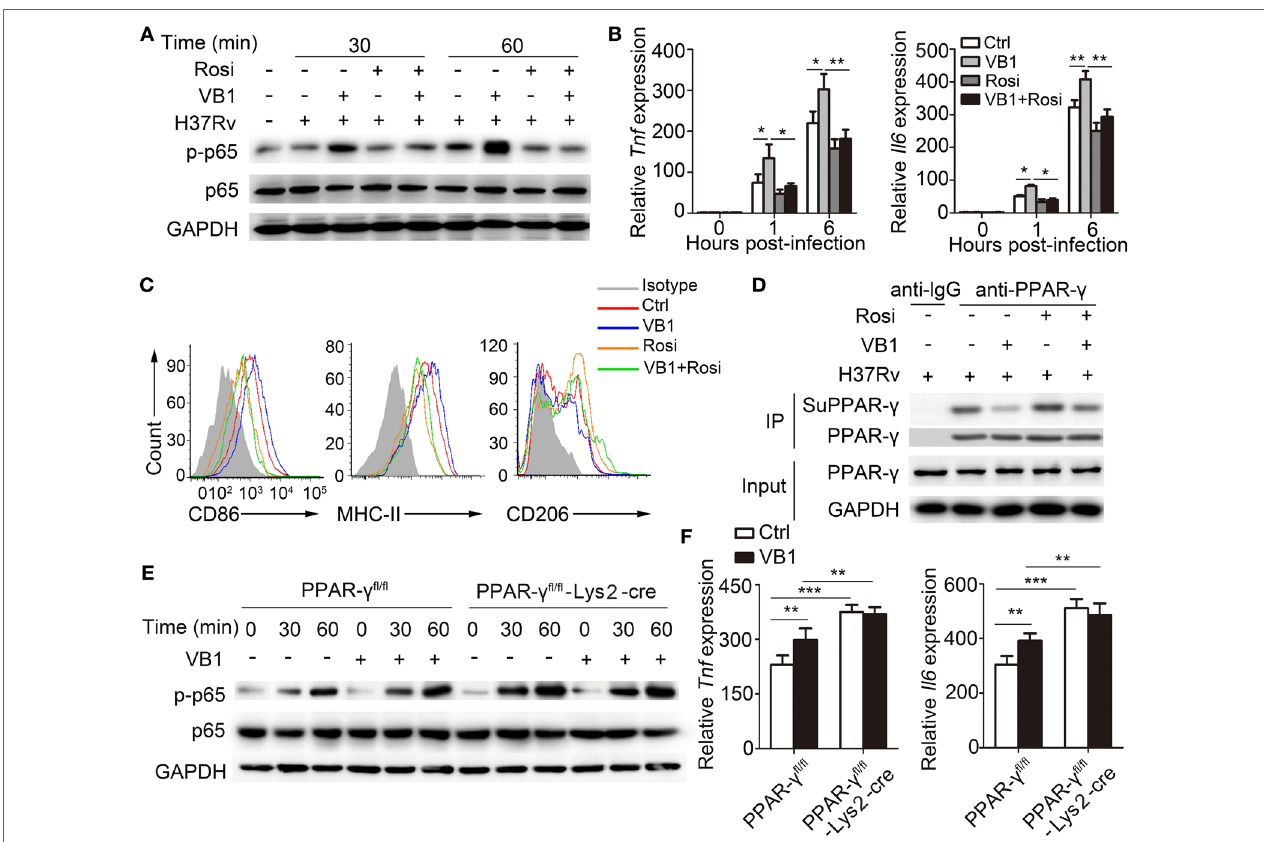
FigUre 5 | Vitamin B1 (VB1) promoted the innate immune response via suppressing SUMOylation of peroxisome proliferator-activated receptor (PPAR- γ ). Bone marrow-derived macrophages (BMDMs) were pretreated with phosphate buffer saline, VB1, Rosi, or mixture of VB1 and Rosi for 24 h and then challenged with Mycobacterium tuberculosis H37Rv (MOI 5) for indicated time. (a) Western blot analysis of the phosphorylation status of p65. GAPDH is as an internal control. (B) Tumor necrosis factor α (TNF- α ) and interleukin-6 (IL-6) mRNA expression determined by real-time PCR. (c) The expressions of CD86, MHC-II, and CD206 were detected via flow cytometry after infection at 24 h. (D) Immunoprecipitation and immunoblots were performed with indicated antibodies. (e) Western blot analysis of the phosphorylation status of p65 in BMDMs from PPAR- γ fl/fl and PPAR- γ fl/fl -Lys2-cre mice. GAPDH is as an internal control. (F) TNF- α and IL-6 mRNA expression determined by real-time PCR in BMDMs from PPAR- γ fl/fl and PPAR- γ fl/fl -Lys2-cre mice. Data shown are the mean ± SD. * P < 0.05, ** P < 0.01, and *** P < 0.001. Data are representative of three independent experiments with similar